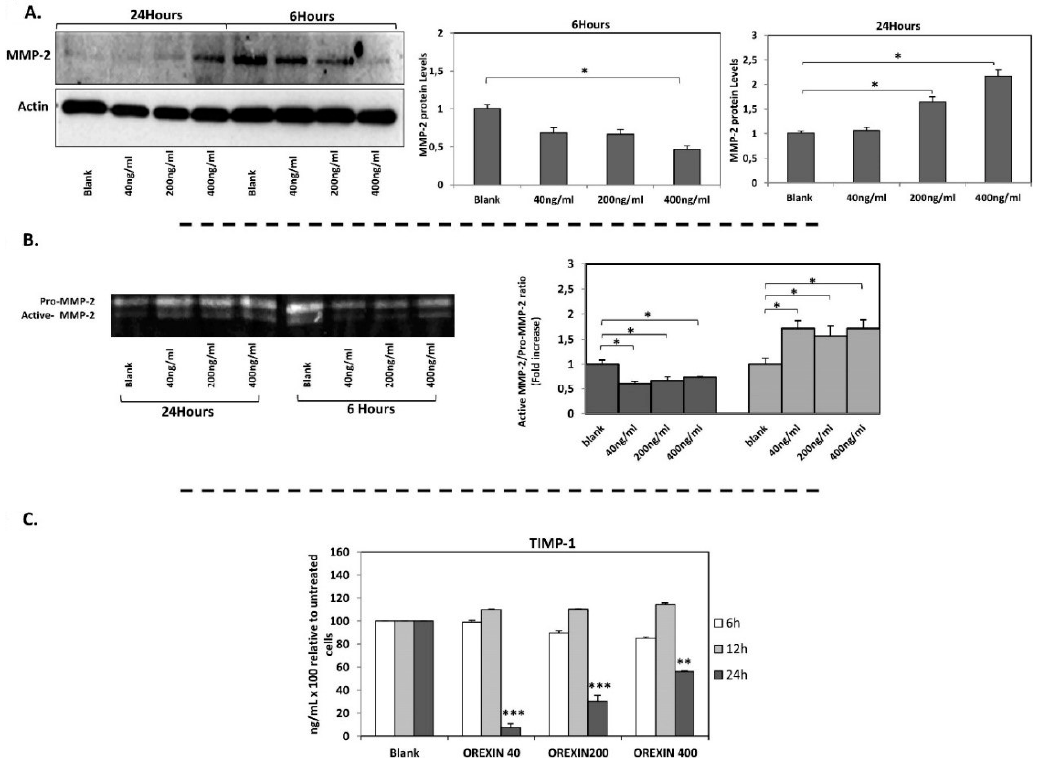
Figure 3. MMP-2 protein levels (Western blotting), MMP-2 gelatinolytic activity (zymogram) and TIMP-1 protein levels (Elisa). ( A ) MMP-2 protein expression was significantly decreased after incubation of cells with orexin-A for 6 h and it was induced after incubation of cells with orexin-A for 24 h. ( B ) The ratio of active MMP-2 / Pro-MMP-2 was significantly reduced after 6 h incubation with various concentrations of orexin-A, while the incubation of cells with orexin-A for 24 h increased the gelatinase activity of MMP-2. ( C ) TIMP-1 protein level was significantly reduced in HAECs after incubation with all concentrations tested (40, 200 and 400 ng / mL) for 24 h. Experiments were performed in triplicate and repeated three independent times. Data are presented as the mean ± SD (*** p < 0.001, ** p < 0.01, * p < 0.05).